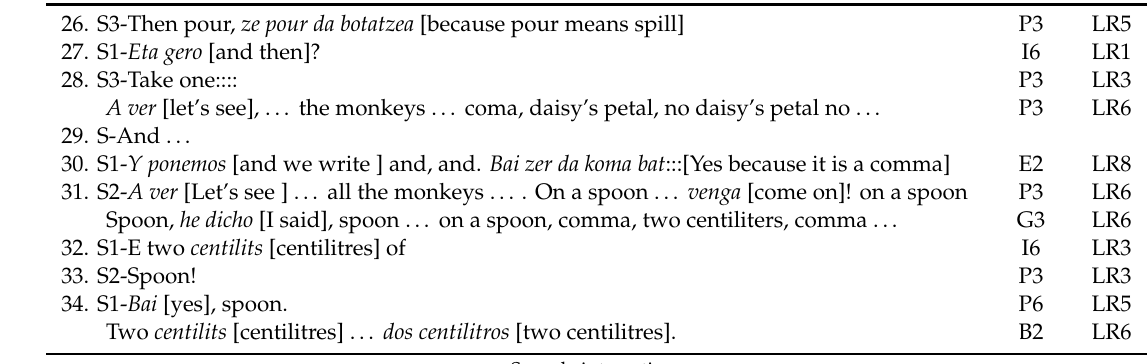
Table 4. Sample interaction.